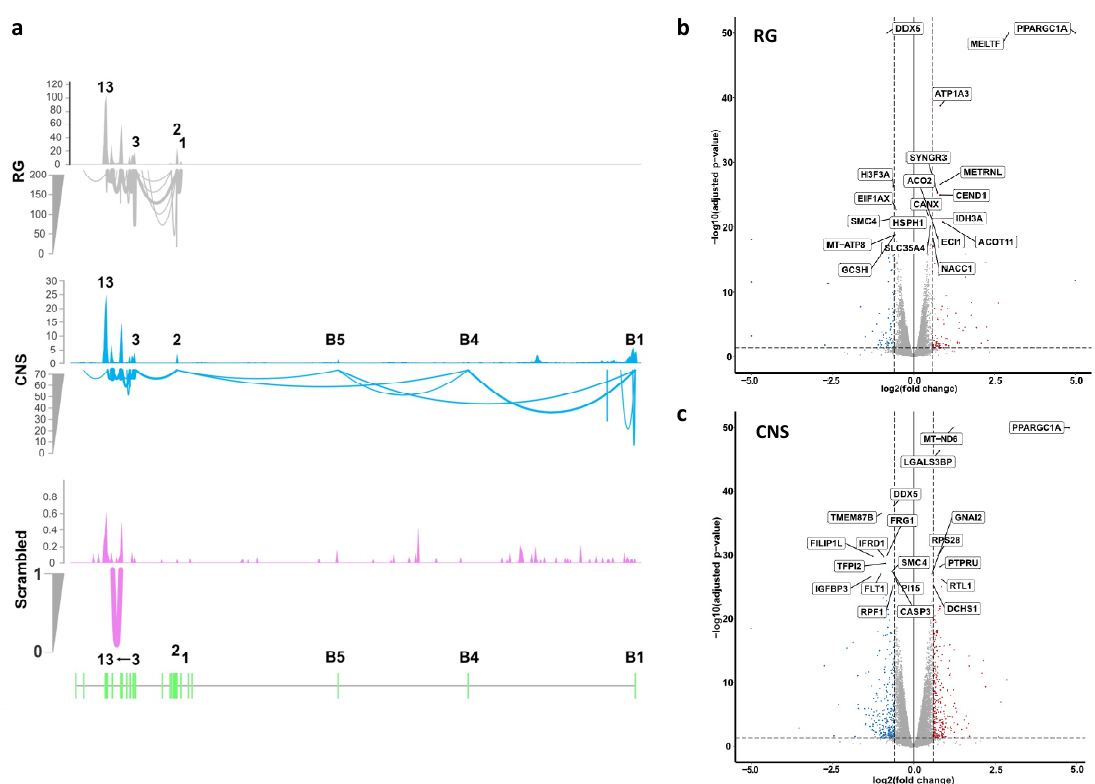
Figure 3. RNA sequencing confirms the predicted structure of transcripts generated by activation of the RG or CNS promoters and reveals differentially expressed genes (DEGs) for either promoter activation. ( a ) Sashimi plots of PPARGC1A transcripts generated by transfection of clonal SH-SY5Y cells expressing dCas9-VPR with sgRNAs activating the RG or the CNS promoters or with scrambled sgRNAs, each merged from three biological replicates; read densities across exons are normalized to obtain comparable measures of expression above the x -axis and normalized single-end junction reads are shown as arcs below the x -axis; structure of visualized exons is shown at the bottom. ( b , c ) Volcano plots of DEGs in cells with RG or CNS activated promoters, respectively, in comparison to cells transfected with scrambled sgRNAs. The top 20 most DEGS are highlighted.